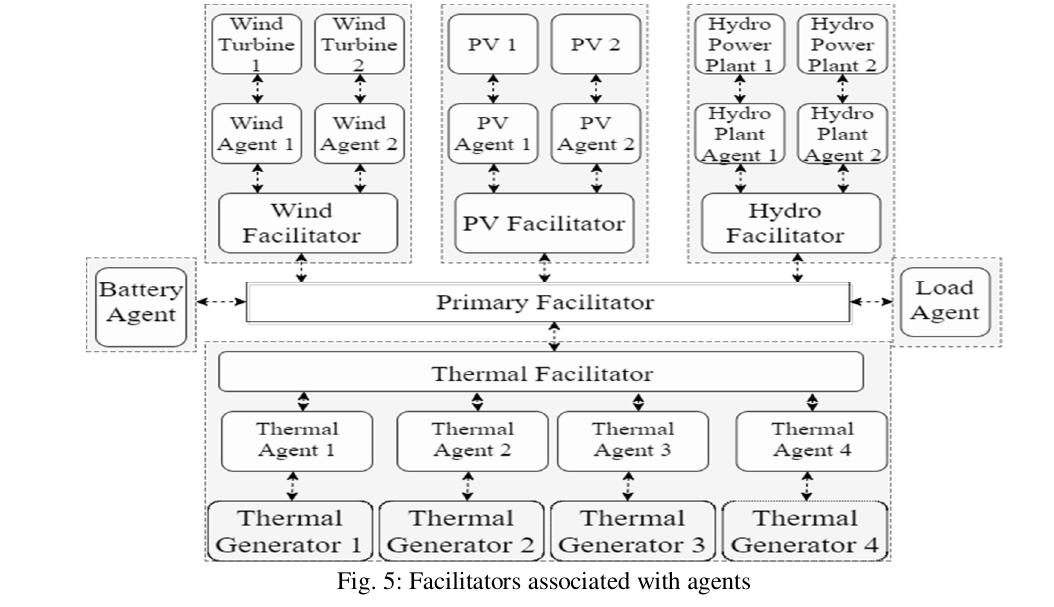
Fig. 5: Facilitators associated with